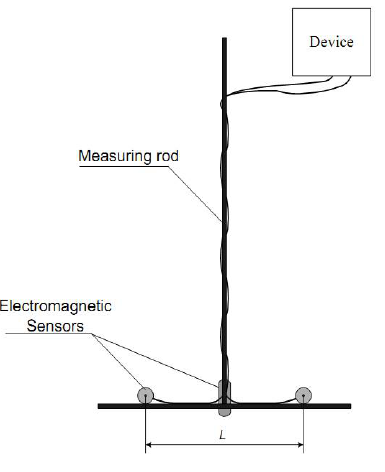
Figure 10. Amplification Units of